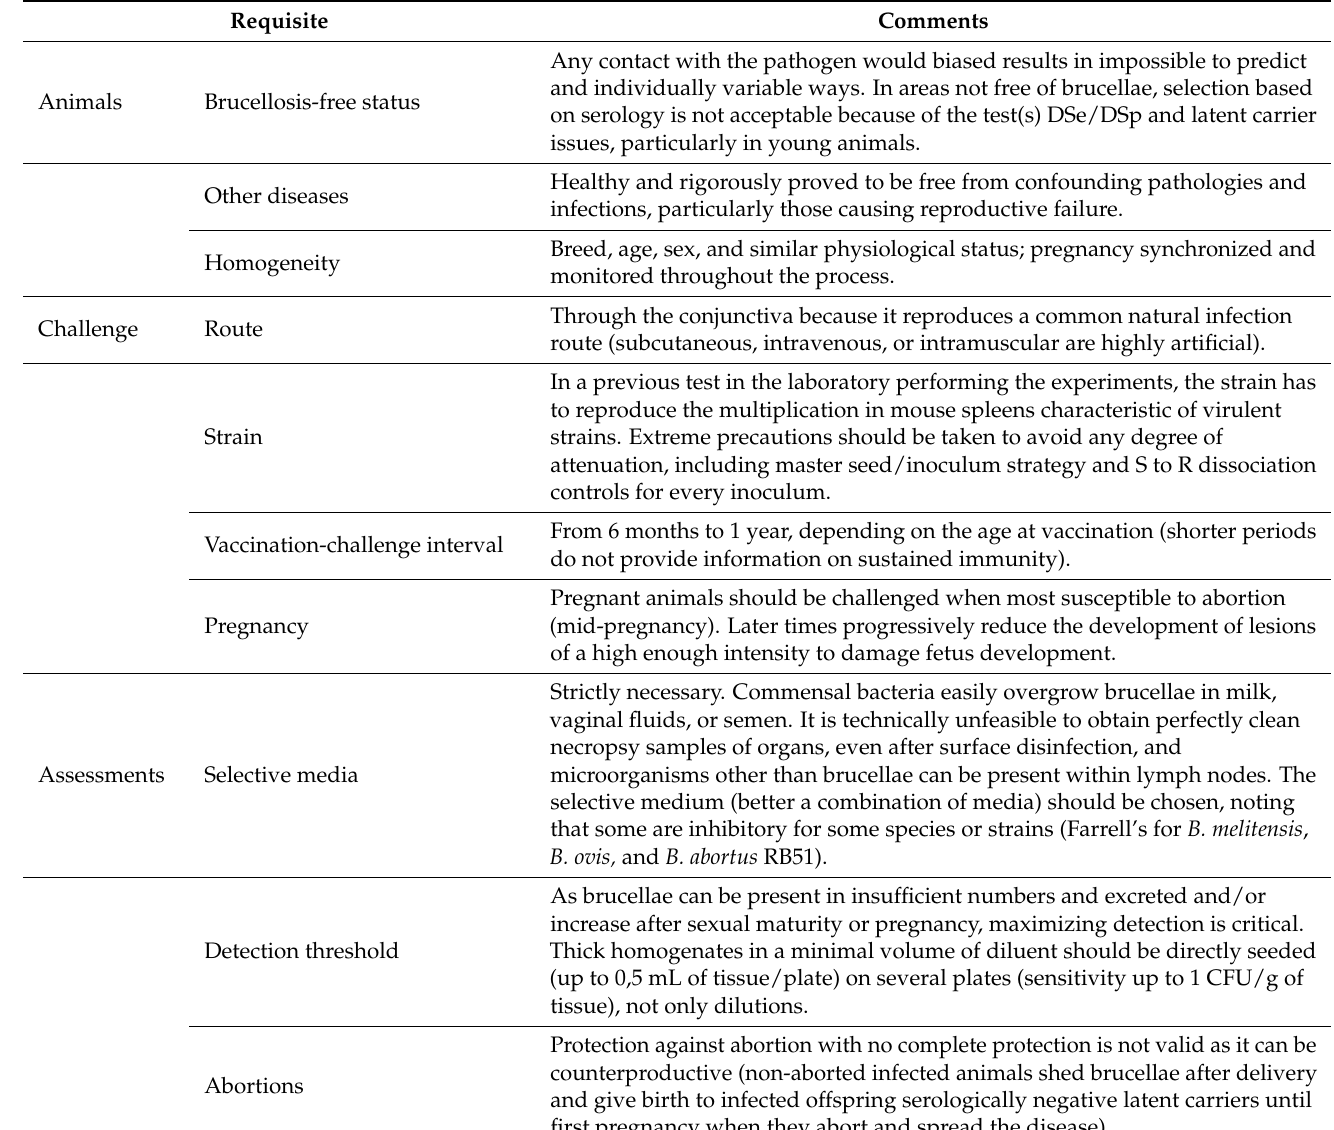
Table 2. Requisites for valid controlled experiments of brucellosis vaccines in target